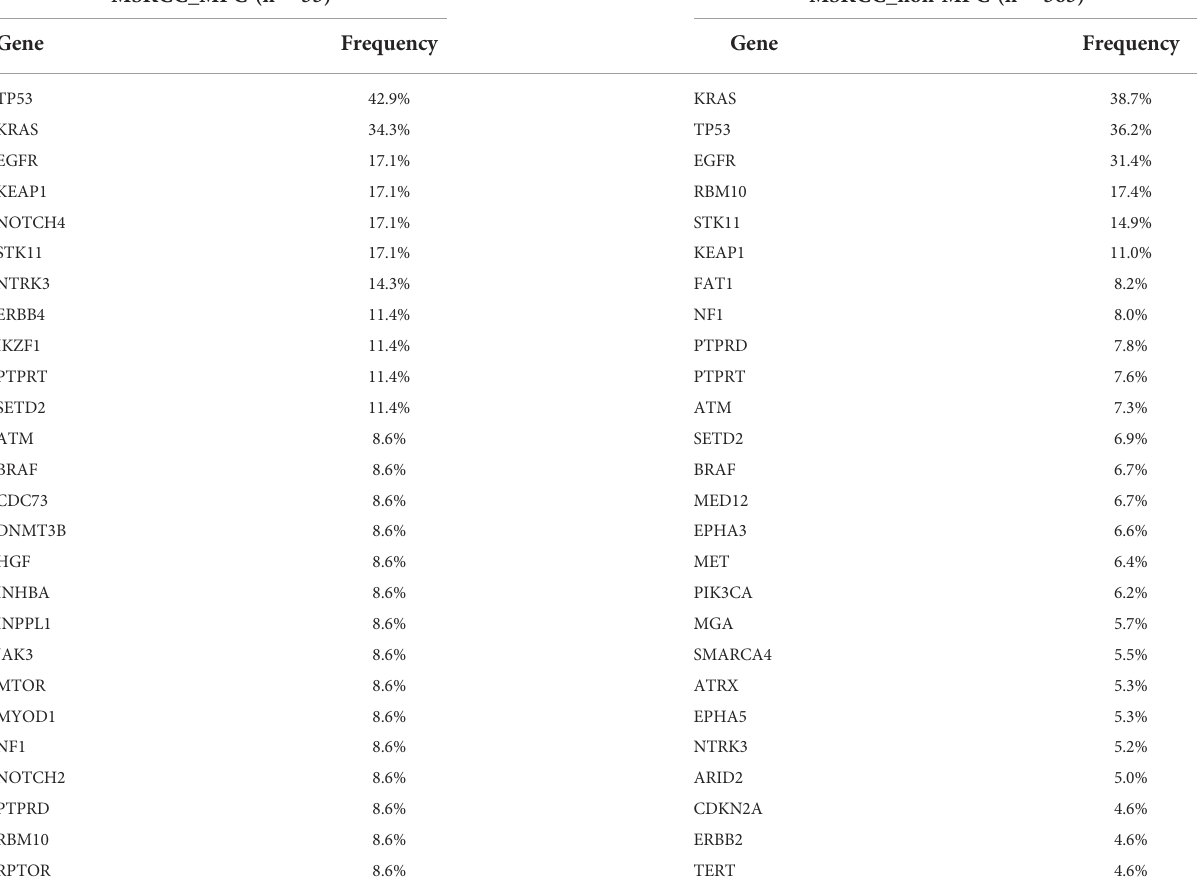
TABLE 3 The top 26 genomic alterations in MSKCC_MPC and MSKCC_non-MPC patients.